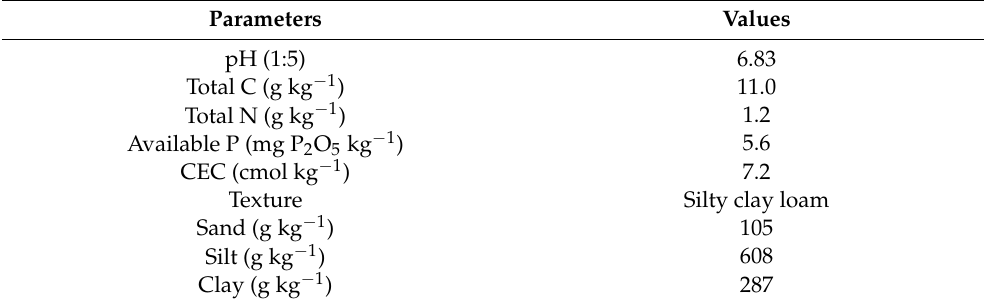
Table 1. Background soil properties of experimental drained paddy fields used for this